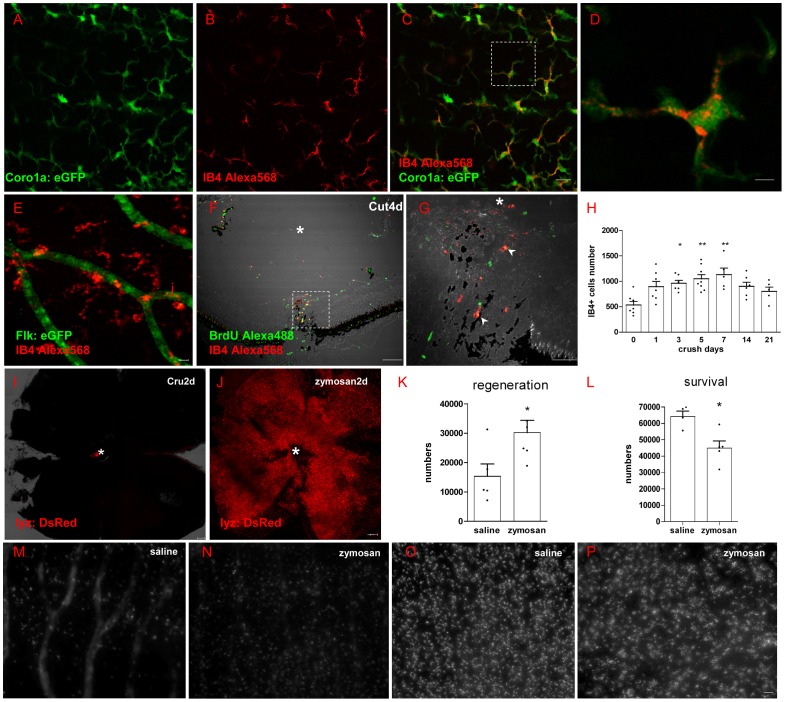
Inflammation has dual-roles during regeneration.(A-D) IB4+ cells in retina are colocalized with coro1a:eGFP in Tg(coro1a:eGFP; lyz:DsRed) fish, which means IB4+ cells mark microglia cells in zebrafish retina. (D) Shows the detailed view of square in (C). (E) IB4+ cells could not colocalize with flk:GFP in transgenic Tg(flk:GFP) line. (F-G) BrdU marker shows that some IB4+ cells are newborn in retina (arrowhead in G), * indicates the lens. (H) IB4+ cells number in all layers of retina changed with time, increasing significantly 3 days to 7 days after ONC, then decreasing to normal level after 14 days. (I-J) Zymosan induces acute neutrophil/macrophage infiltration into retina, * indicates optic disc. (K, M and N) Neutrophil/macrophage infiltration into retina could increase the number of regenerated RGCs in the first week after ONT, but decrease RGCs survival after 2 weeks (L, O and P). * indicates p<0.05, ** is p<0.01. Scale bar: 10 µm (A-C, M-P); 2 µm (D); 30 µm (G), 100 µm (F, I and J).